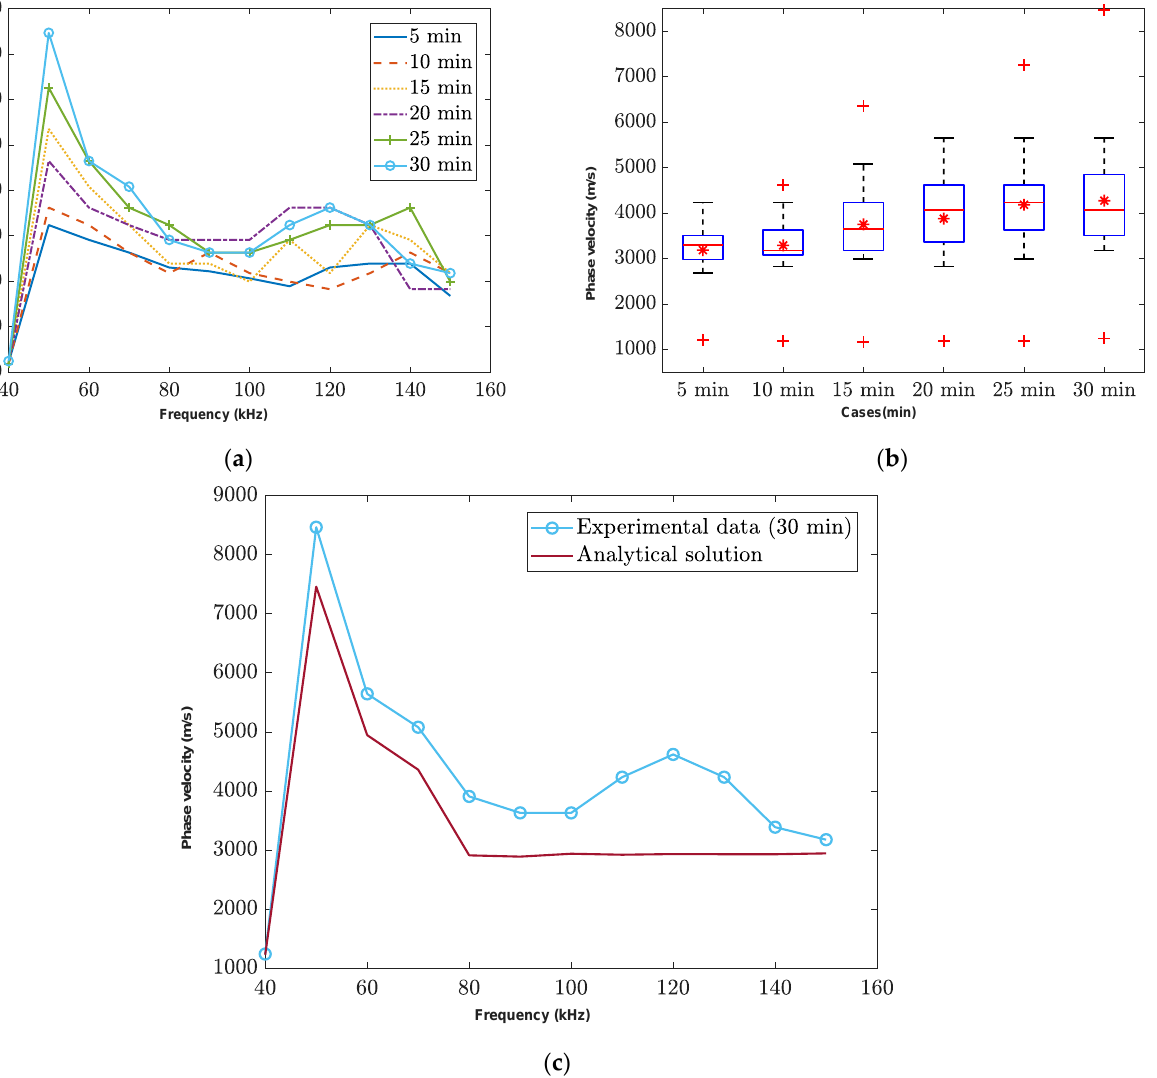
Figure 6. The phase velocity of P - wave experimental data analysis. ( a ) phase velocity with six different scanning time, ( b ) the boxplot of different time cases, and ( c ) the comparison between analytical solution and experimental data.